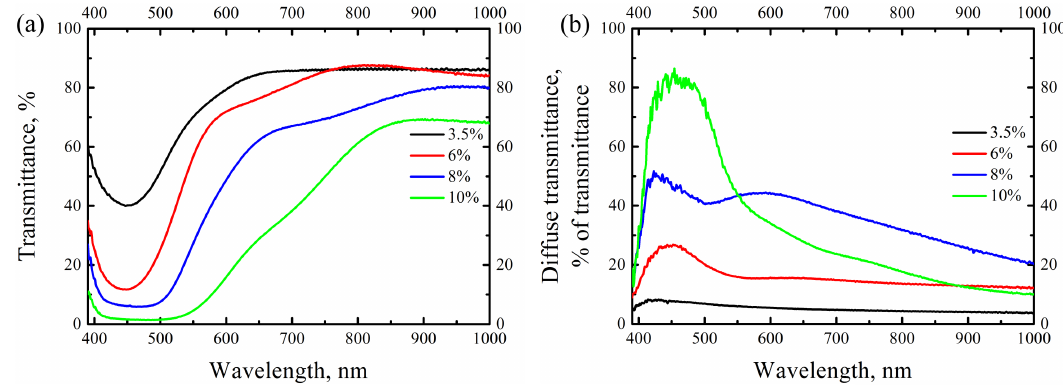
Figure 6. The dependences of ( a ) the total transmittance, ( b ) the diffuse transmittance (in % of total transmittance) on the wavelength for the PPX+Ag coatings with the different volume concentrations of silver (3.5%, 6%, 8%, 10%) at normal incidence.